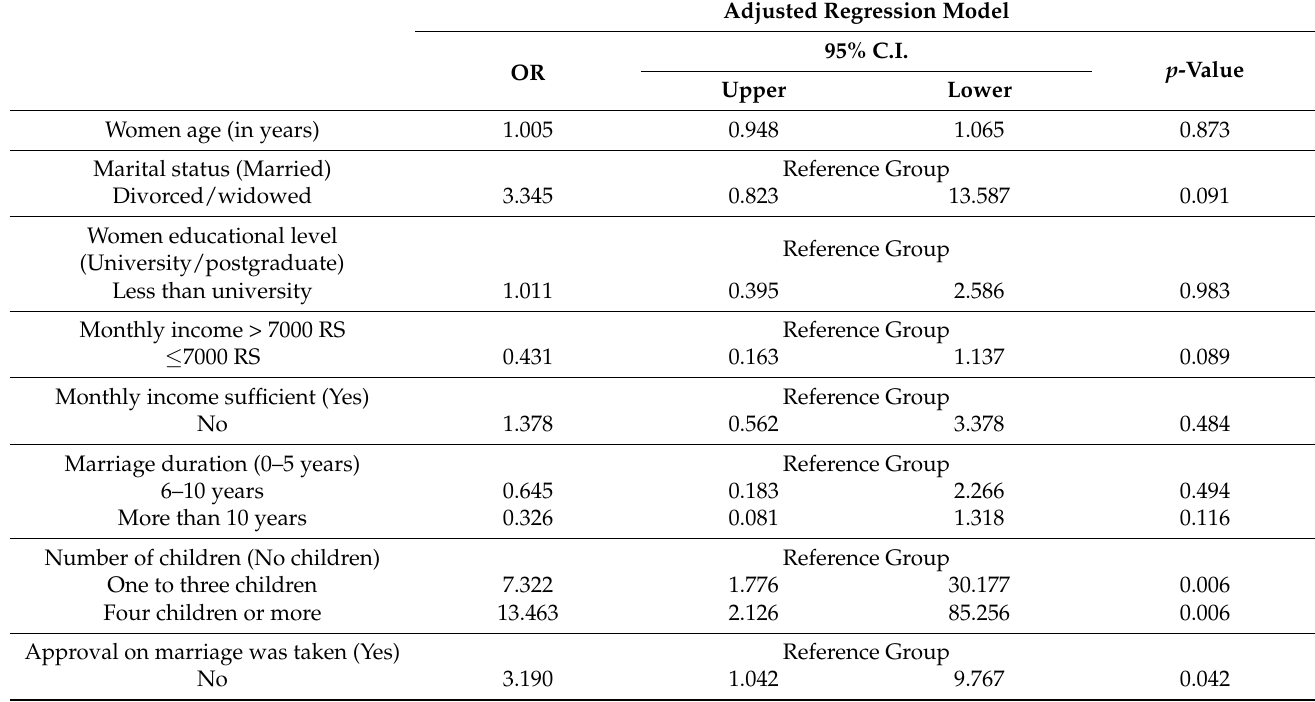
Table 4. Logistic regression revealing the predictors of IPV among women attending different primary health centers in Aljouf region, Saudi